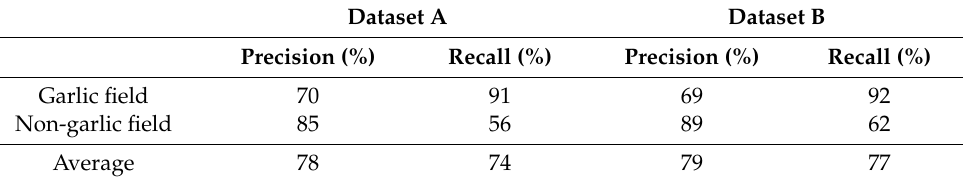
Table 17. Precision and recall of garlic classification model generated using the MLC method.